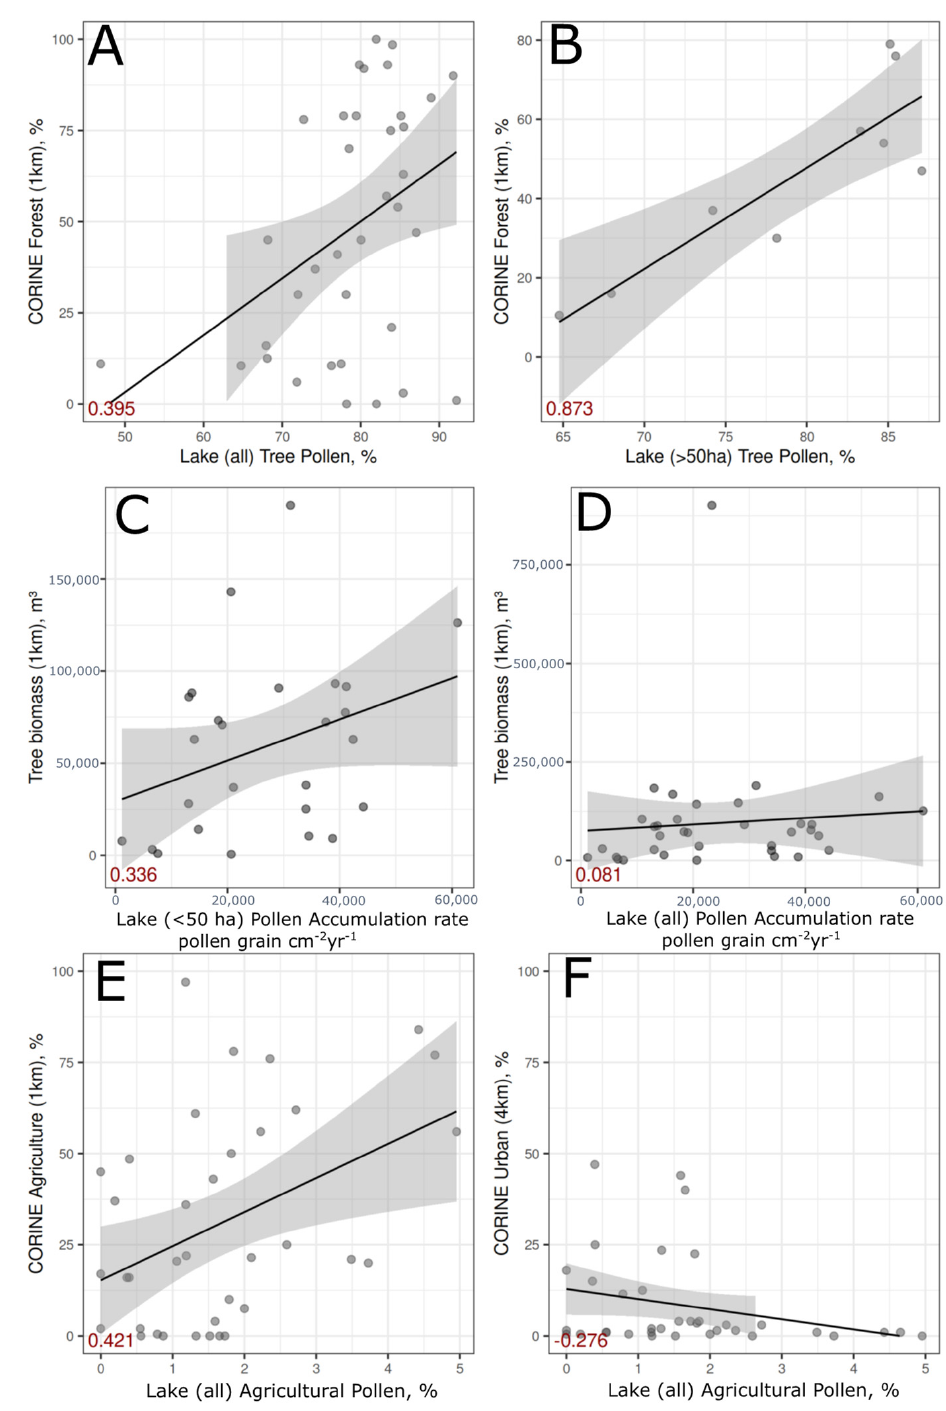
Figure 6. Pearson correlation of ( A ) relative share of forest (%, CORINE based estimates) within 1 km around the waterbodies and tree pollen (%) from all study sites, ( B ) relative share of forest (CORINE based estimates) within 1 km around the large lakes and tree pollen (%) from large lakes (>50 ha), ( C ) tree biomass (m 3 ) within 1 km around the large lakes and tree pollen concentration (pollen grains per sample) from large lakes (>50 ha), ( D ) tree biomass (m 3 ) within 4 km around all waterbodies and tree pollen concentration (pollen grains per sample) from all sites, ( E ) agricultural fields (%) within 1 km around all waterbodies and agricultural (cultivated vegetation) pollen (%) from all sites and ( F ) urban area (%) within 4 km and agricultural (cultivated vegetation) pollen (%) from all sites. Gray shading represents 95% confidence level.